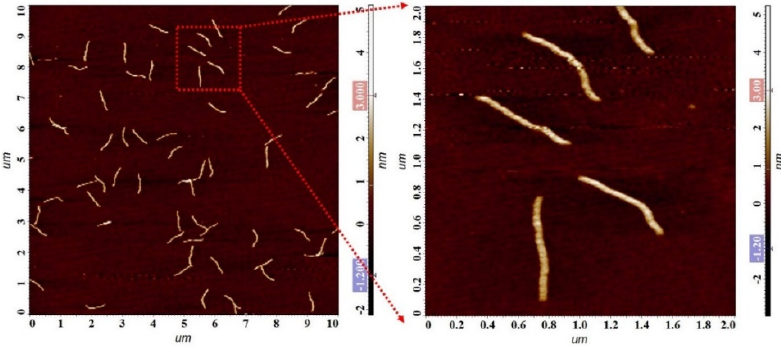
Figure 3. AFM images of the M13 phage display